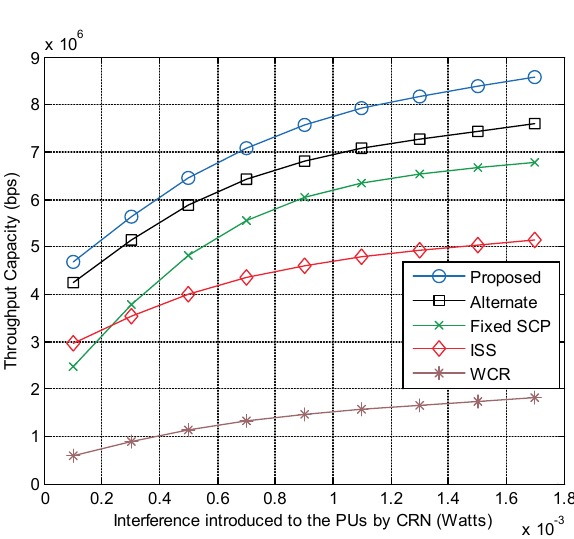
Figure 4. Maximum achievable sum rate of the CRN versus interference introduced to the PUs by several. observe that Alternate scheme, where the sensing